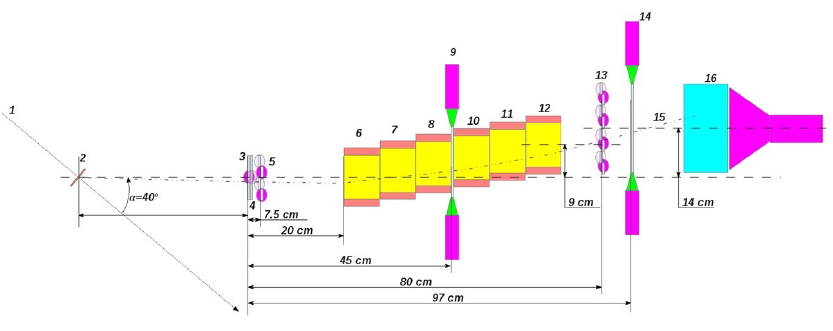
Figure 5. A layout of the setup